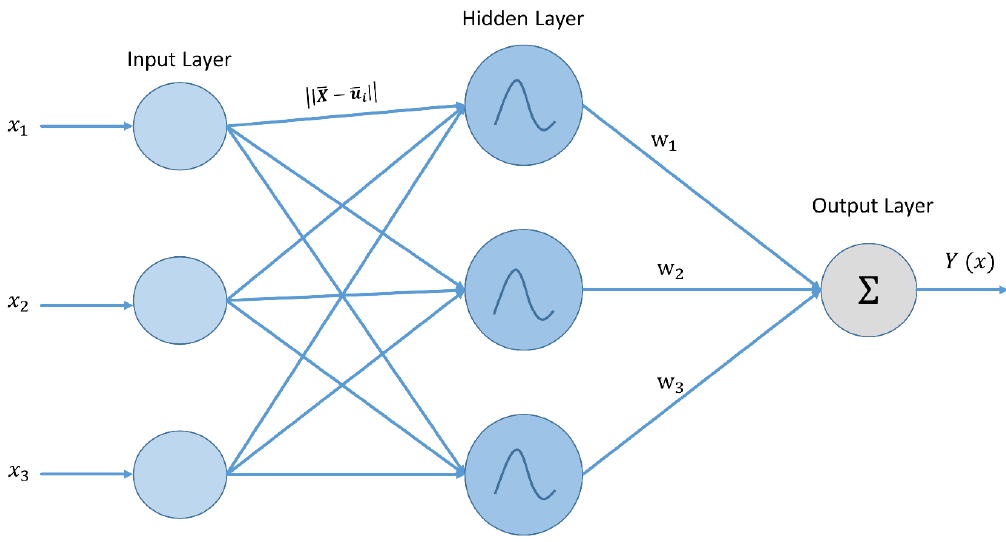
Figure 6. Radial Basis Function Neural Network.